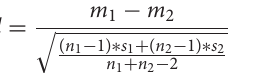
TABLE 2 | Demographic characteristics for the AIBL dataset.